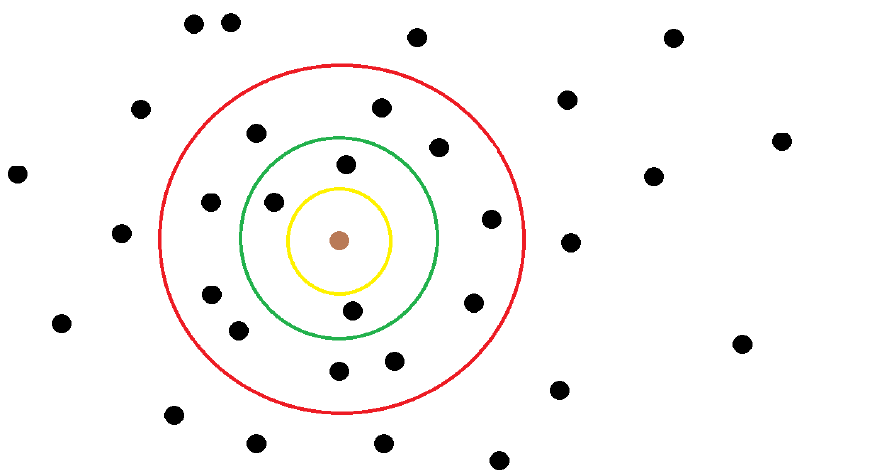
Figure 4. The procedure of formation of the rings for the finding of the “near anchor nodes”. The source node is coloured brown, while the initial radius of the ring is the yellow one, the second one is green and the biggest of all is red. In the first ring, the source node has no near anchor nodes at all, while in the second and third ring, it has 3 and 13 anchor nodes,